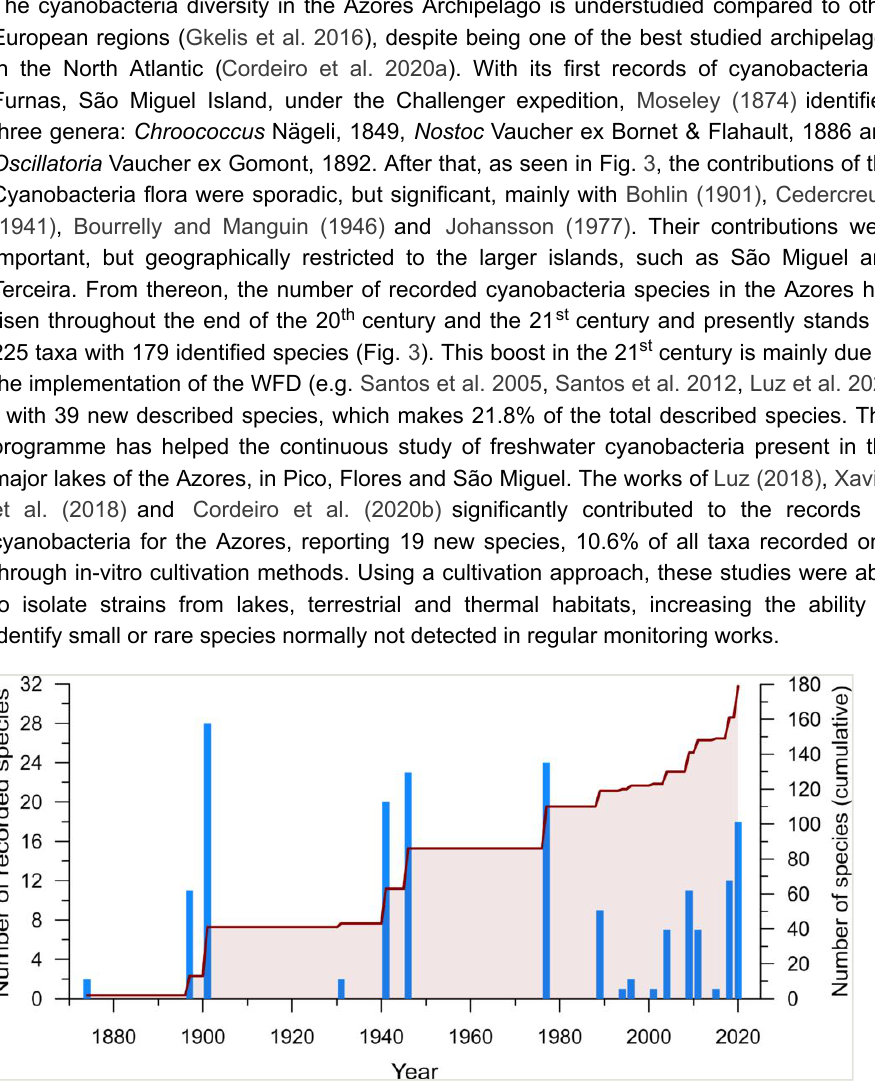
The number of described species through time from 1874 to 2020. Bars represent the number of species described per year, the line represents the cumulative number of described